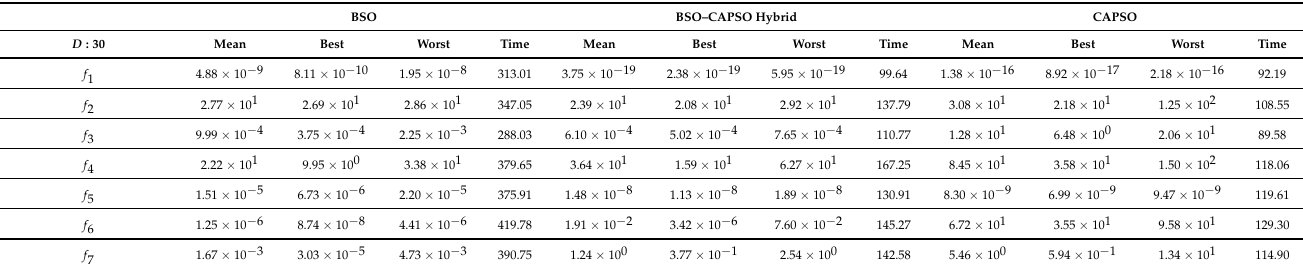
Table 5. Simulation results for D =